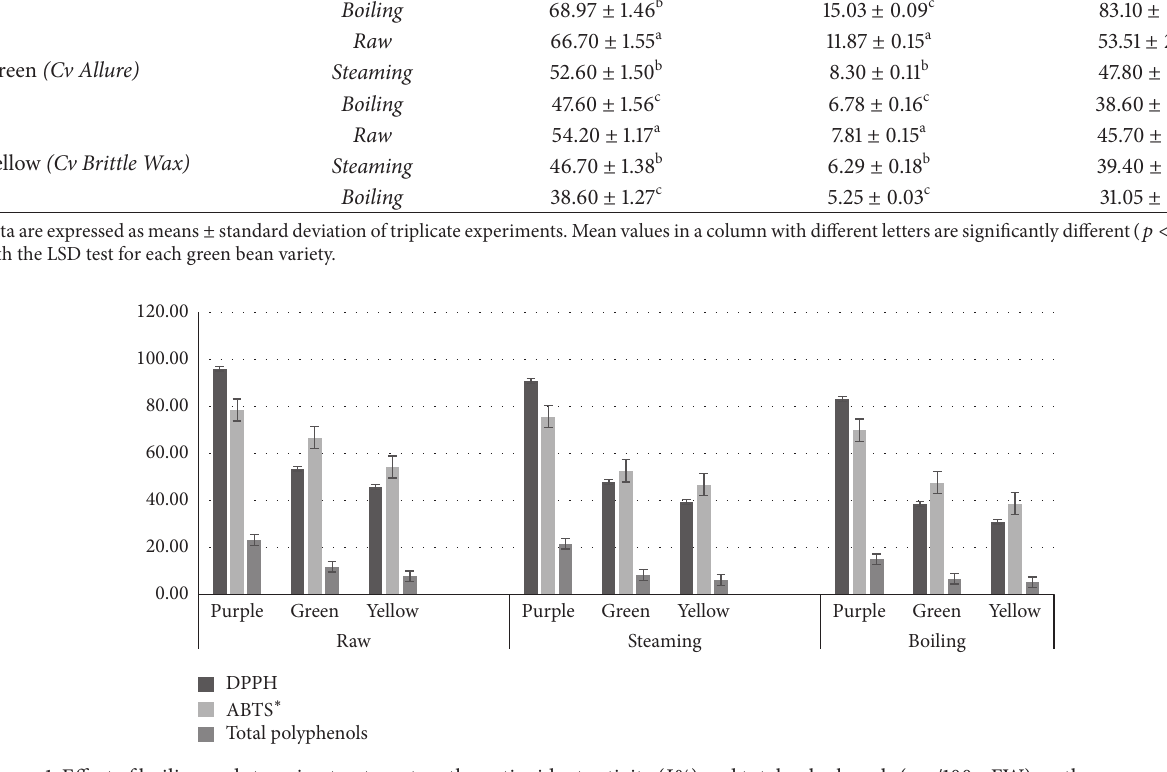
Figure 1: Effect of boiling and steaming treatment on the antioxidant activity (𝐼 % ) and total polyphenols (mg/100g FW) on three green beans